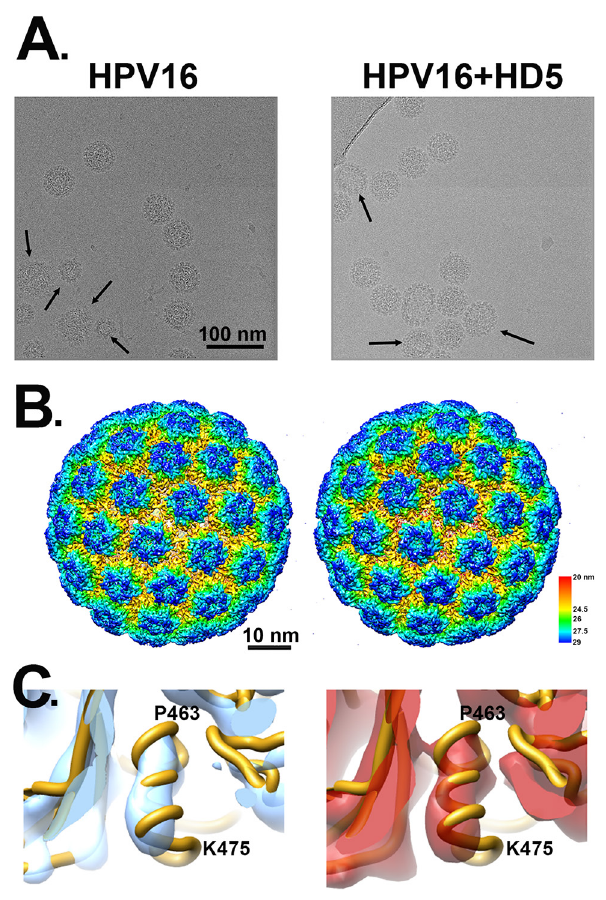
Figure 1. CryoEM of HPV16 and HPV16+HD5. (A) Representative cryo-electron micrographs of HPV16 (left) and HPV16+HD5 (right). Arrows point to capsids with heterogeneous size or shape. Scale bar = 100 nm. (B) Radially colored representations of HPV16 (left) and HPV16+HD5 (right). Scale bar = 10 nm. (C) Enlarged views of the HPV16 (left) and HPV16+HD5 (right) cryoEM maps showing α-helical density in L1 (aa 463-475, chain E) in both